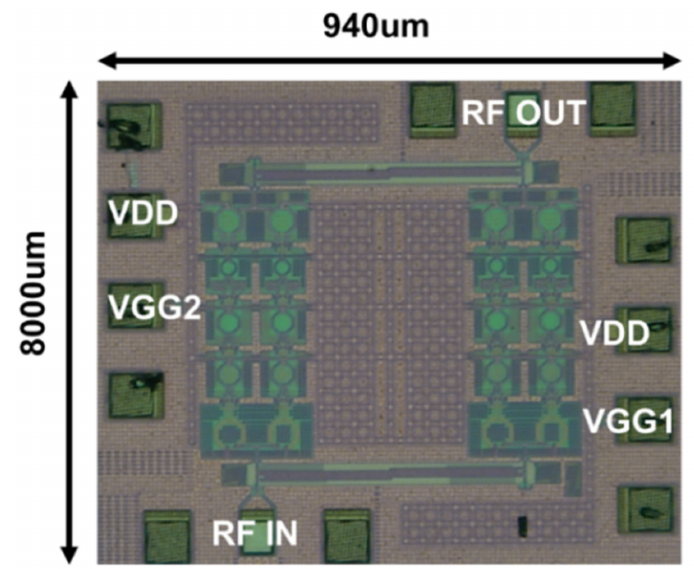
Figure 12. Chip photograph with the size of 0.94 mm × 0.8 mm including RF pads and DC